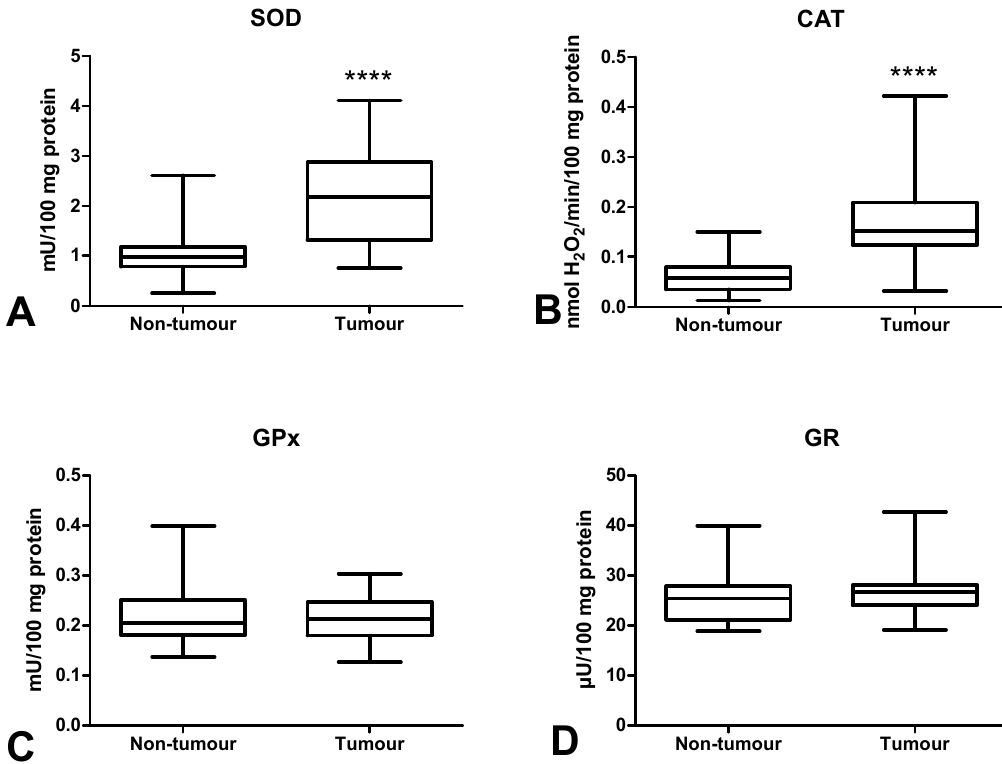
Figure 3. Comparison of SOD ( A ), CAT ( B ), GPx ( C ) and GR ( D ) activity between colorectal cancer tissue ( n = 29) and normal mucosa ( n = 29). The data are presented as median (minimum–maximum).